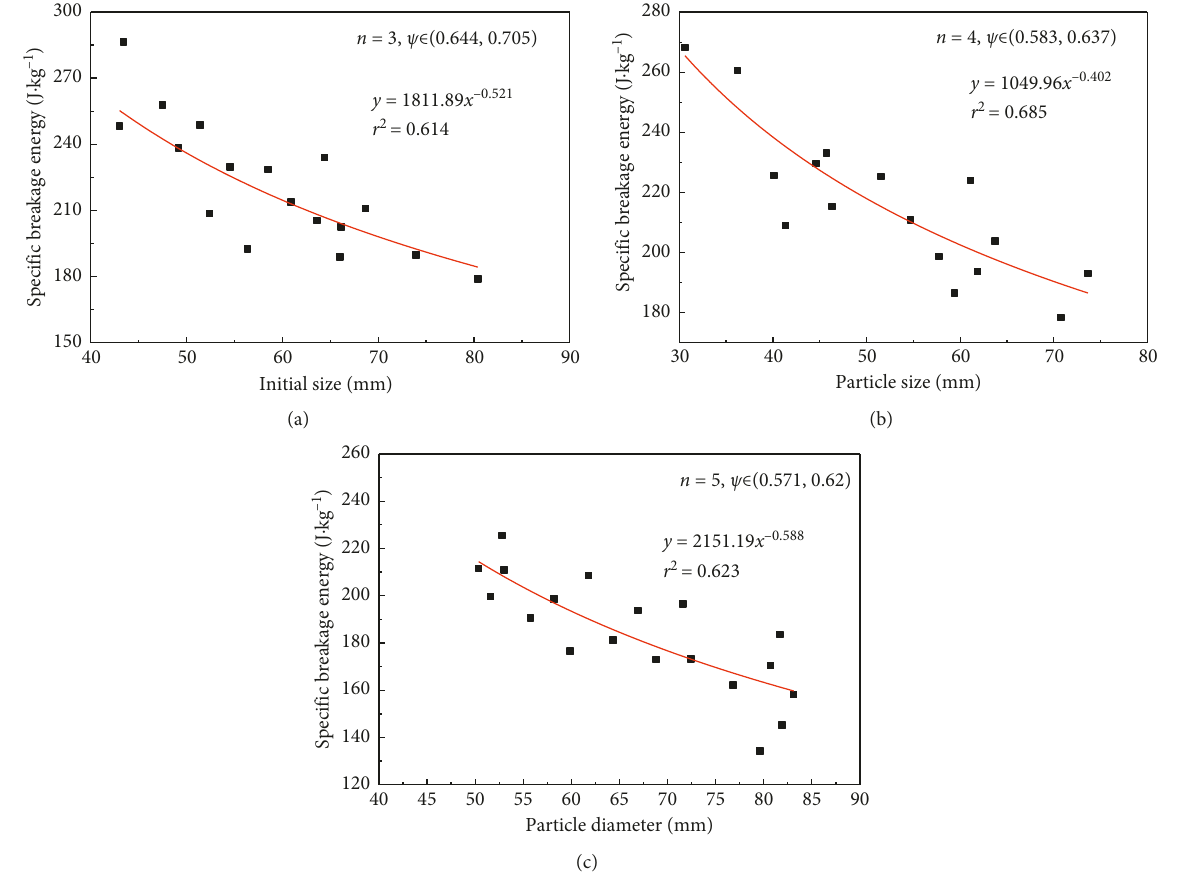
Figure 12: Relationship between specific breakage energy and initial